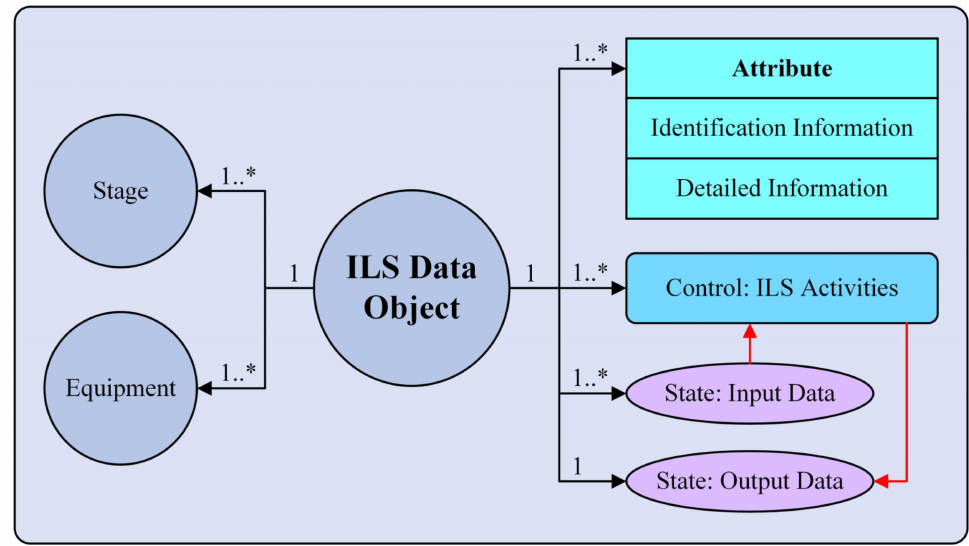
Figure 6. ILS Domain unified data model